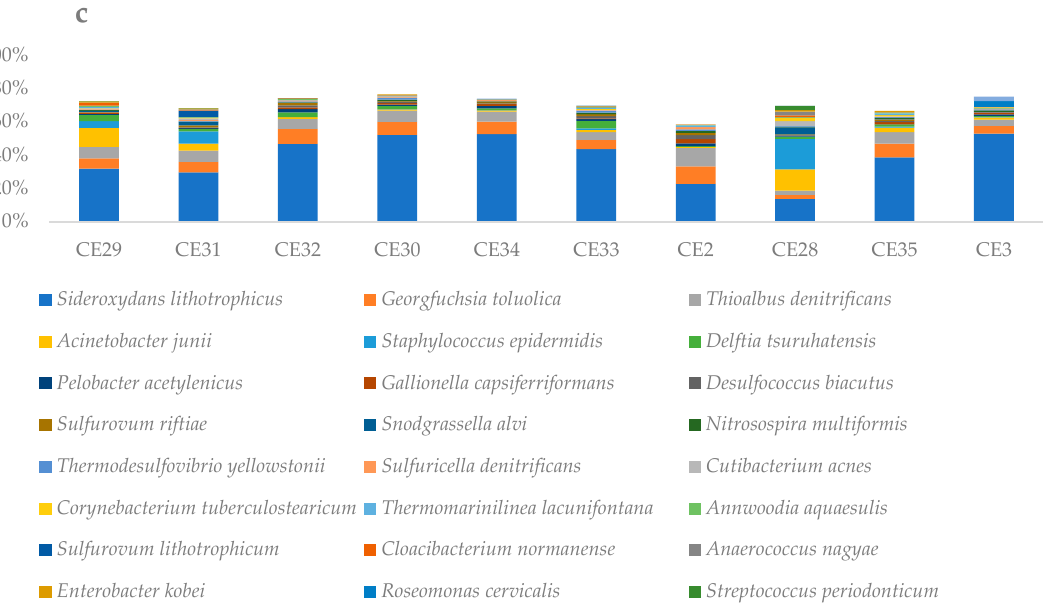
Figure 6. The relative abundance of the 25 best represented taxa in the three studied springs. ( a ): Banpotoc; ( b ): Baita; ( c ): Rapoltel.